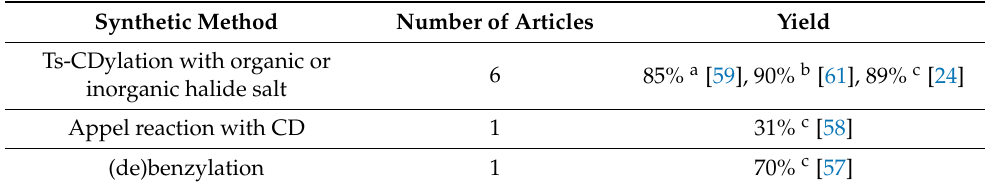
Table 2. Preparation of 6 A -deoxy-6 A -halogens of